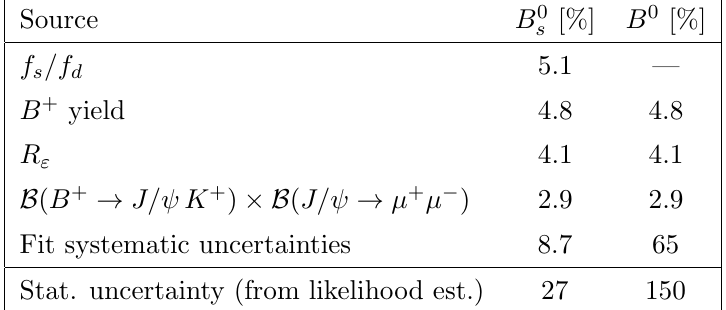
! (cid:22) + (cid:22) (cid:0) ). The measure- ( s )